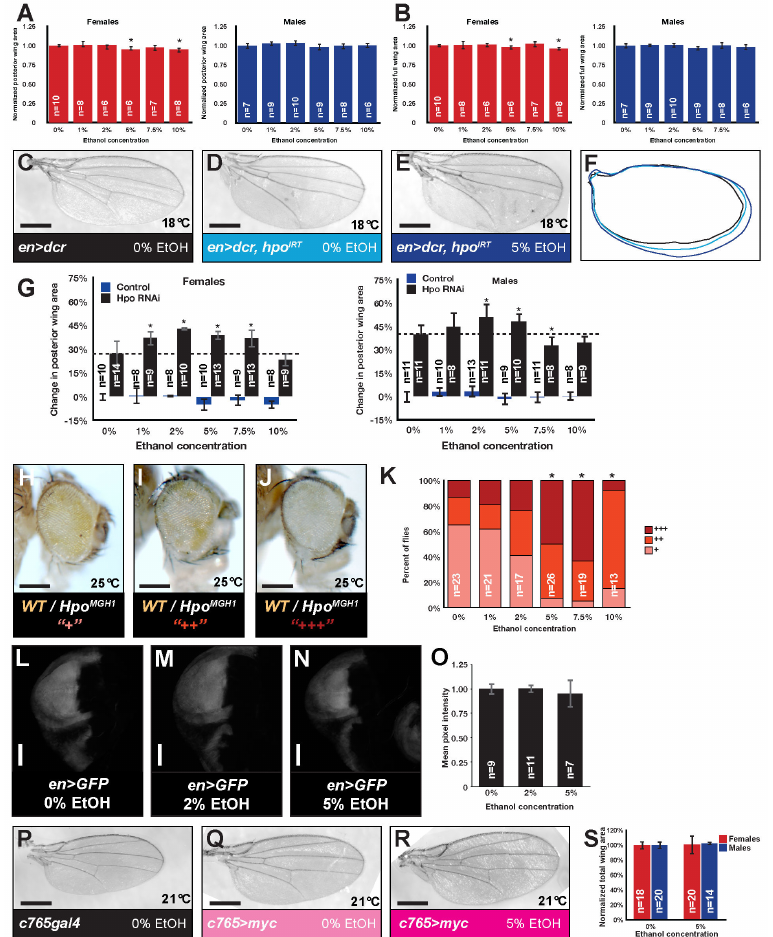
Figure 1. Dietary ethanol enhances overgrowth associated with loss of hpo . (A-B) Quantification of the effects of 1-10% ethanol on the posterior wing area (A) and whole wing area (B) of control flies (normalized to area of control wings on 0% ethanol). * indicates p=0.023995 for females at 5% and p=0.000633 for females at 10% in A and p=0.016029 for females at 5% and p=0.001122 for females at 10% in B. (C) Control wing. (D) hpo RNAi in the posterior wing. (E) Ethanol-mediated enhancement of wing overgrowth upon hpo knockdown. (F) Wing tracings from C-E highlight size changes. C-E, representative female wings. (G) Graph showing percent change in posterior wing area compared to controls at 0% ethanol for RNAi to hpo (black) and controls (blue) for food containing 0%, 1%, 2%, 5%, 7.5%, and 10% ethanol (normalized to areas of control flies treated with 0% ethanol). * indicates p=0.00224 (1%, females), p=0.00979 (2%, females), p=0.00589 (5%, females), p=0.00104 (7.5%, females), p=0.00730 (2%, males), p=0.02938 (5%, males), and p=0.01457 (7.5%, males). (H-J) Mutation in hpo ( hpo MGH1 ) results in over-representation of mutant tissue (white) compared to wild-type tissue (red) [50]. Mosaic eyes fall into a range of over-representation from the mildest ratio scored as “+” (H) to moderate “++” (I) and severe “+++” (J). (K). Ethanol enhanced over-representation of mutant tissue in a mosaic eye, noted by the increase in “++” and “+++” eyes. This phenomenon was observed most strongly at 5% and 7.5% ethanol. Wild-type tissue in a mosaic eye serves as an internal control. We saw no gender differences; graph represents combined data for males and females. * indicates p=1.33E-10 (5%), p=3.97E-11 (7.5 %), and p=8.1E-6 (10%) compared to the same genotypes on 0%. (L-N) Images of wing discs expressing a GFP transgene under the control of engal4 in flies reared on food containing (L) 0% ethanol, (M) 2% ethanol, and (N) 5% ethanol. Scale bar on wing disc images reflects 100 micrometers. (O) Graph reflecting quantification of GFP based on pixel intensity shows no change in GFP in flies reared on ethanol (p>0.05). (P) Control wing. (Q) Myc over-expression across the wing from a fly grown on control food. (R) Myc over-expression across the wing from a fly grown on food containing 5% ethanol. (S) Graph showing wing area for flies reared on 5% ethanol compared to controls at 0% ethanol for myc over-expression. Wing area is normalized to 100% for myc-expressing flies reared on 0% ethanol. Genotypes for this and subsequent figures are detailed in Materials and Methods. The number of flies analyzed in each experiment in this figure and subsequent figures is shown in parentheses on the base of each column. The bars in each graph in this figure and subsequent figures indicate Standard